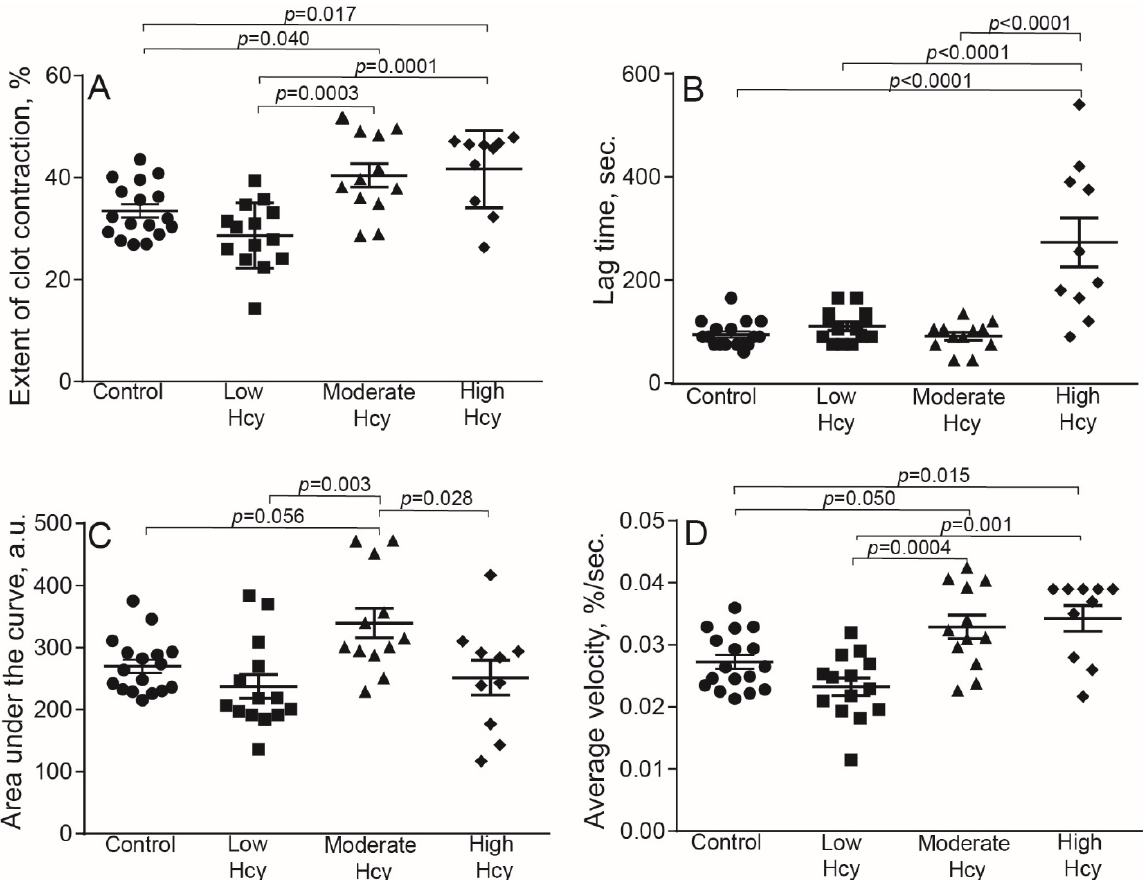
Figure 4. Parameters of blood clot contraction in clots made from the blood of control and HHcy rats as a function of Hcy levels in plasma: normal control (3.5–7.8 μ M, n = 17), low in methionine-resistant rats (3.6–9.9 μ M, n = 14), moderately elevated (10–50 μ M, n = 12) and high (51–122 μ M, n = 10). Parameters analyzed: extent of contraction ( A ); lag time ( B ); area under the contraction kinetic curve—work done by platelets ( C ); average contraction velocity ( D ). Mean ± SEM, ordinary one-way ANOVA, post-hoc Tukey’s test. Only significant differences are shown ( p < 0.05). Table 3. Blood composition of control rats compared to the HHcy rats with low, moderate, and high Hcy levels. Parameters